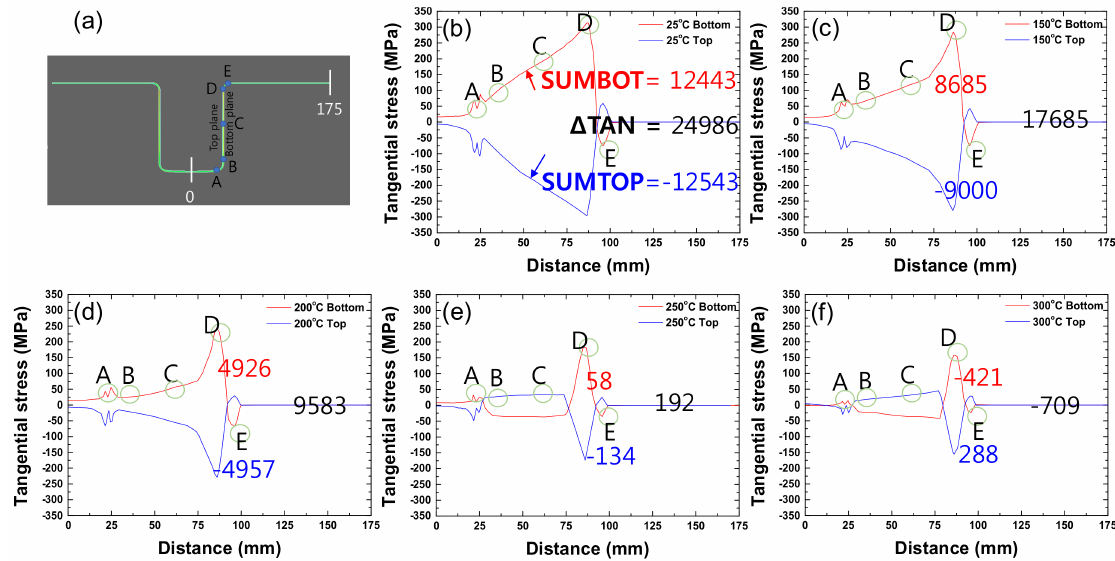
Figure 6. The tangential stress values in ( a ) each distinct tooling region at the top and bottom layers of the blank (under isothermal condition) at ( b ) 25, ( c ) 150, ( d ) 200, ( e ) 250 and ( f ) 300 ◦ C. For all cases, the punch speed was 1